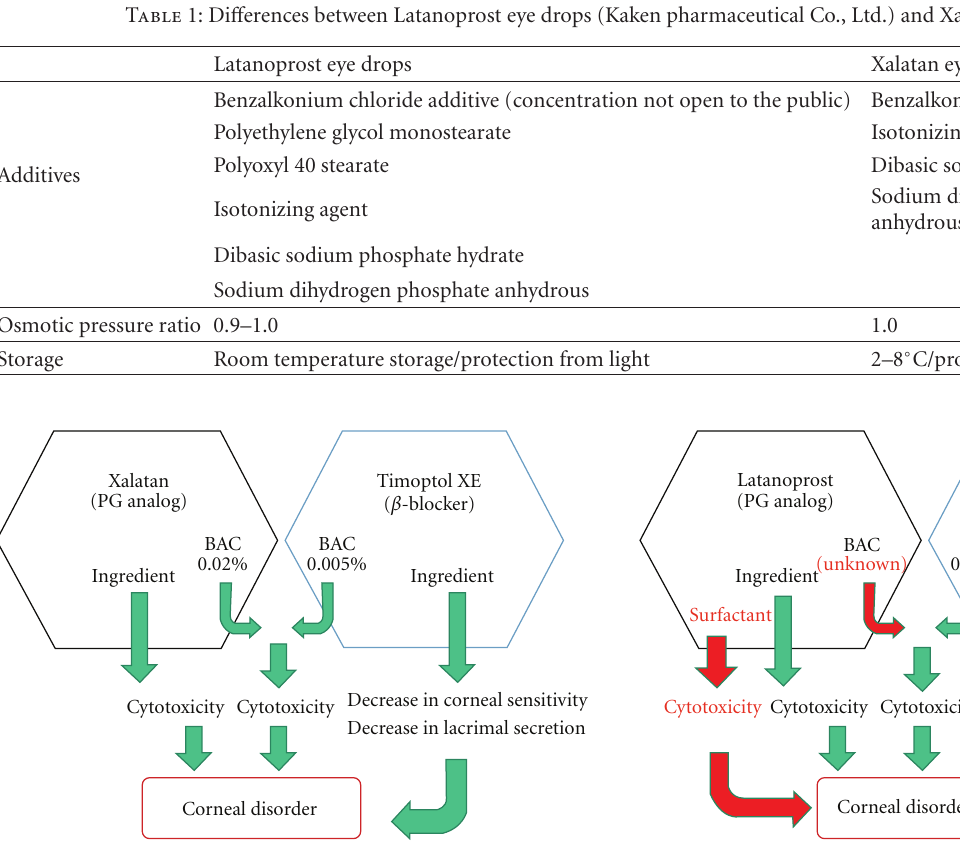
Figure 4: Mechanism of the development of corneal epithelial disorder suggested by the clinical history of this patient. The cyto- toxicity of the surfactant may have added to the cytotoxicity of the main component and BAC in Lataronrost eye drops similar to that of Xalatan eye drops. Its use in combination with Timoptol XE eye drops, which decreases corneal sensitivity and lacrimal secretion, may have induced corneal